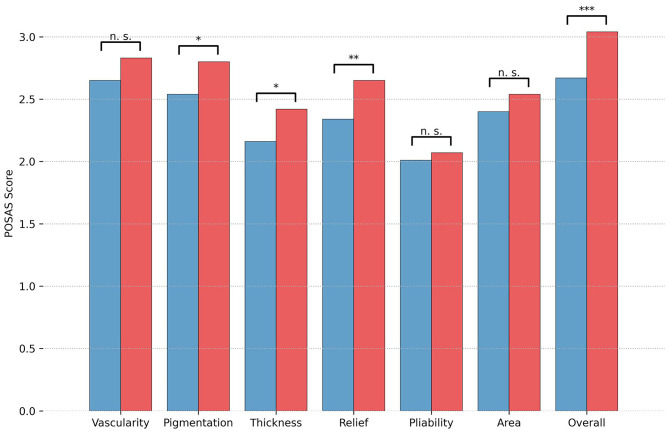
Mean Observer score of the Patient and Observer Scar Assessment Scale (POSAS) at late follow-up (at 6–12 months). Results are depicted separately by treatment group (blue = group 1, tissue adhesive; red = group 2, suture) for each of the POSAS items and for the POSAS Overall score; and significance levels are indicated. Significance levels are indicated (*p < 0.05, **p < 0.01, ***p < 0.001).